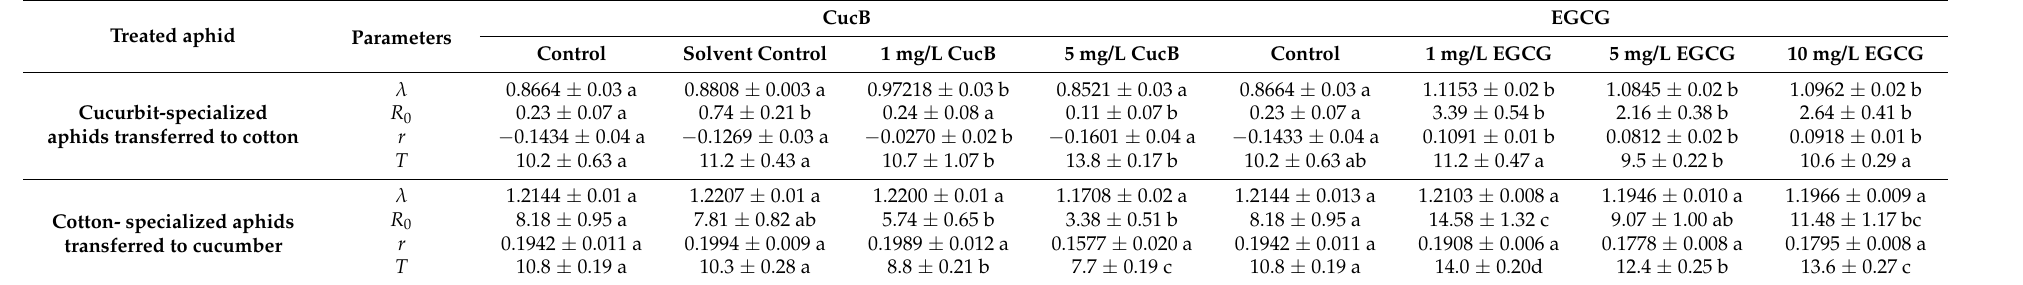
Table 4. Effects of CucB and EGCG on F 1 population parameters of Aphis gossypii on nonhost